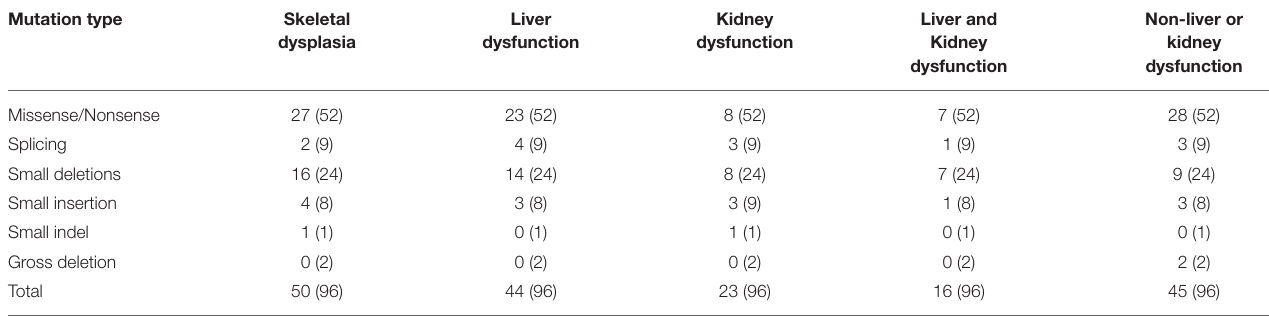
TABLE 1 | The variations and clinical